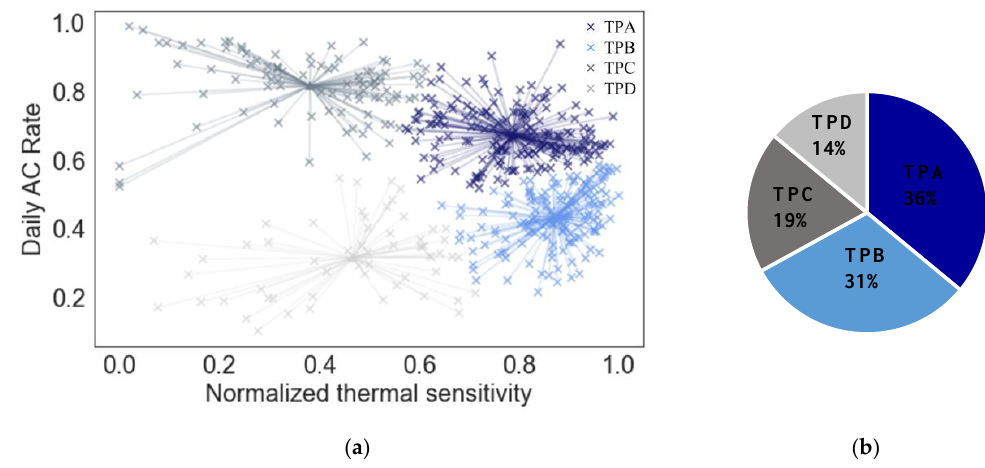
Figure 11. Clustering results of thermal preference patterns across 482 dwellings. ( a ) Four typical clusters of thermal preference pattern. ( b ) Share of each cluster.